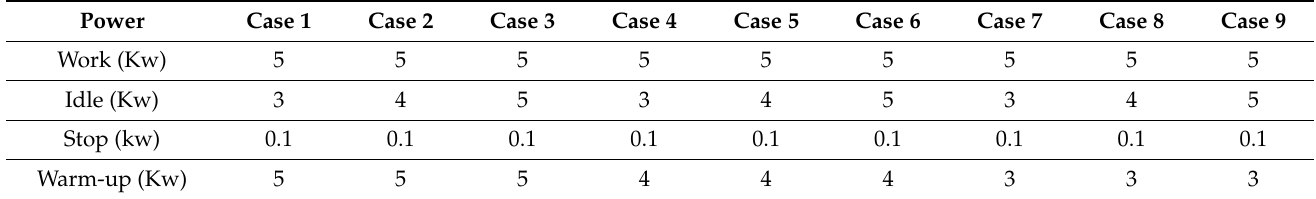
Table 3. Power sensitivity